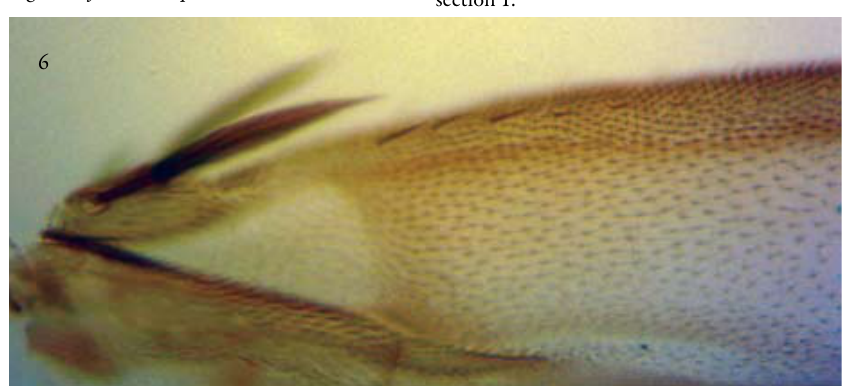
Fig. 6. Rhynchomicropteron nudiventer male, costal section 1, with a few costal cilia at